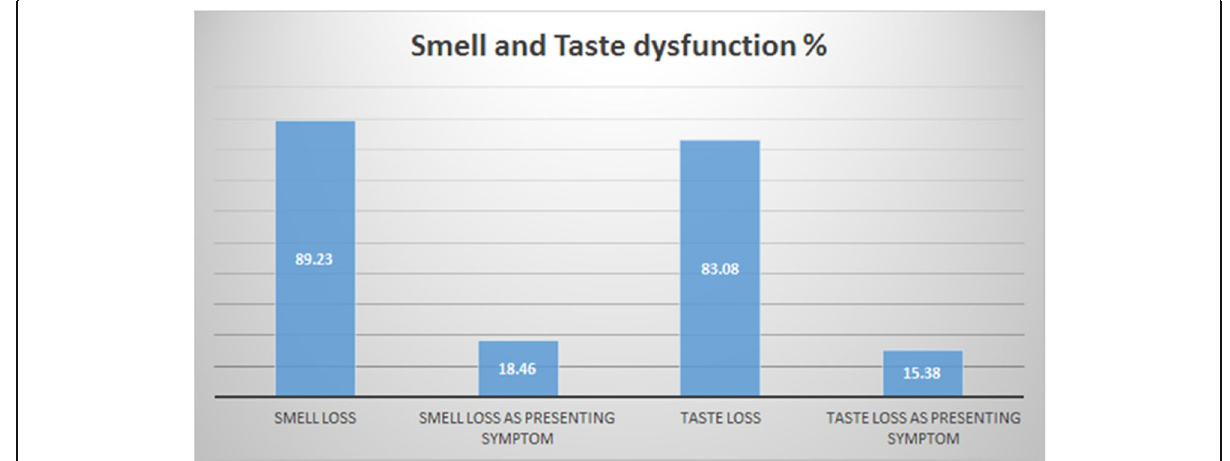
Fig. 1 The percentage of smell and taste loss in general and as the only presenting symptom of COVID-19